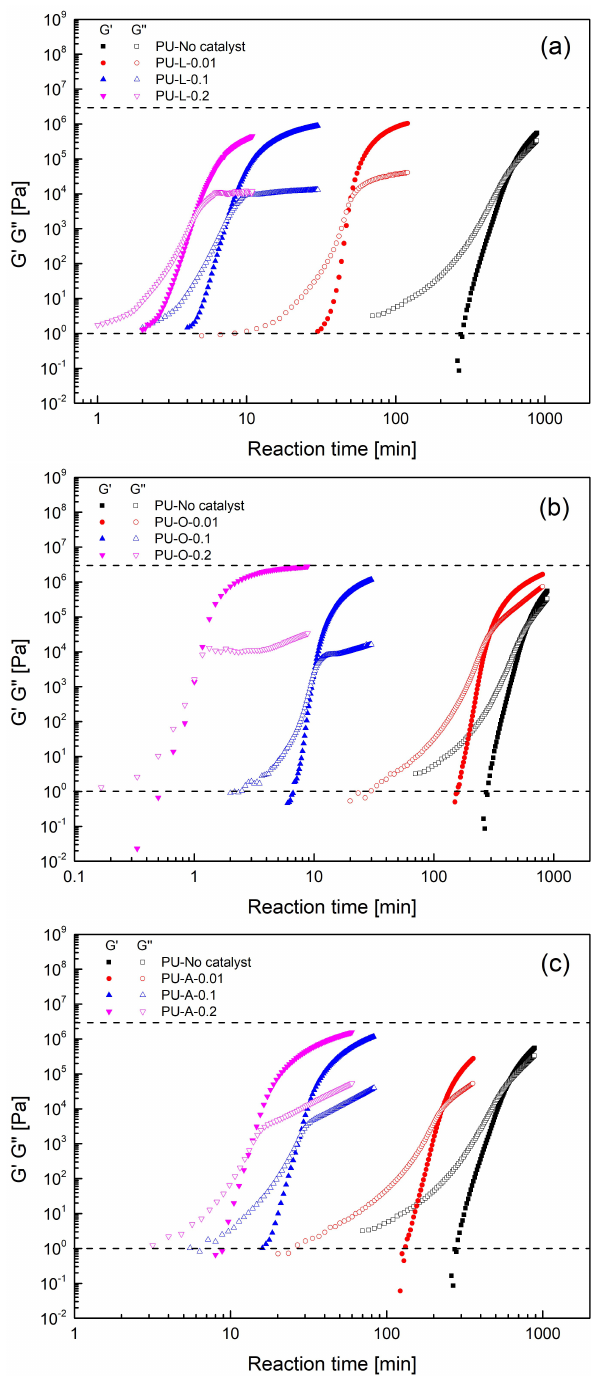
Figure 4: Time sweep tests for polyurethane compounds with no catalyst and with the different accelerating catalysts